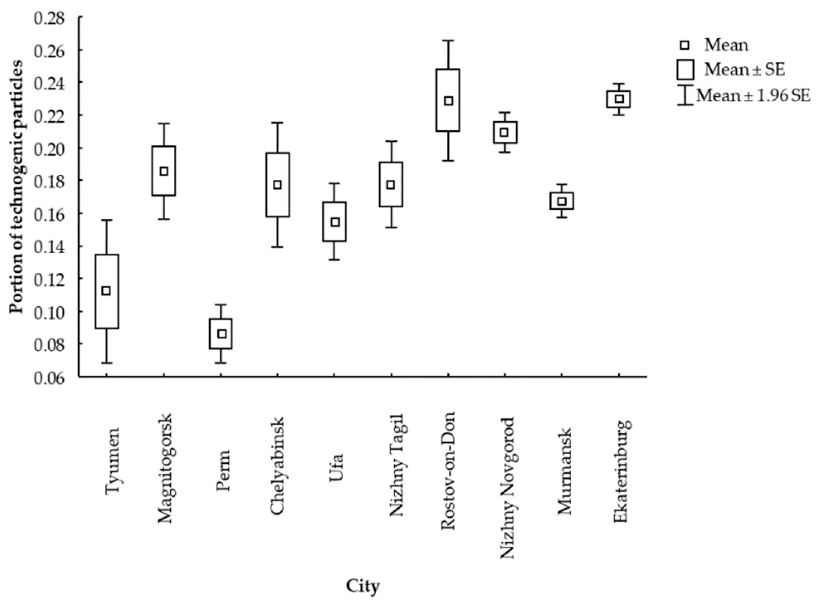
Figure 2. The proportion of technogenic particles in the cities in the particle size fraction of 0.1–1 mm (SE—standard error).